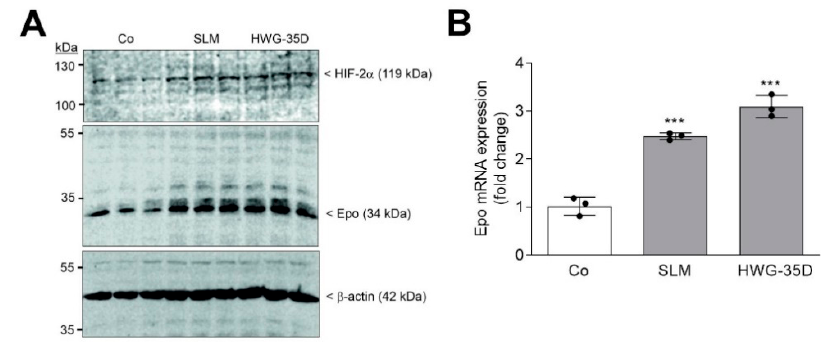
Figure 5. The selective Sphk2 inhibitors SLM6031434 and HWG-35D affect HIF-2 α and Epo in primary mouse fibroblasts. Confluent wildtype primary fibroblasts were incubated for 16 h in serum- free DMEM prior to stimulation for 6 h with either vehicle (Co) of 3 µM of SLM6031434 (SLM), or HWG-35D. ( A ) Protein was analyzed by immunoblotting using antibodies against HIF-2 α (top panel), Epo (middle panel), or β -actin (bottom panel). Corresponding bands were evaluated by Image Studio Lite software (version 3.1, LI-COR Biosciences, Lincoln, NE, USA), normalized to β -actin and are presented in Figure S7. ( B ) mRNA was analyzed by qPCR using primers for mEpo, and mL28 mRNA for normalization. ∆∆ Ct values were calculated and results show the fold change compared to the untreated control and are means ± S.D. ( n = 3), *** p < 0.001 were considered statistically significant when compared to the control